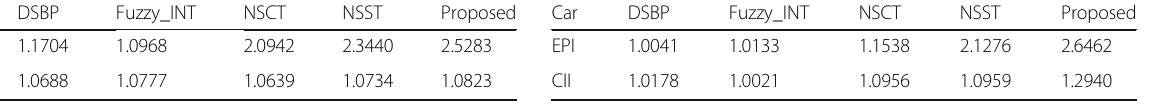
Table 1 Objective evaluation parameters for Lena image set Lena